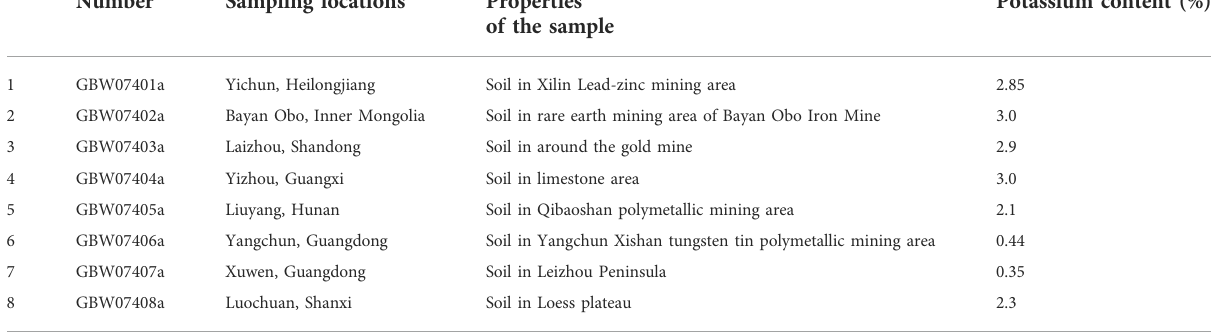
TABLE 1 Sample labels, locations, and properties used in the